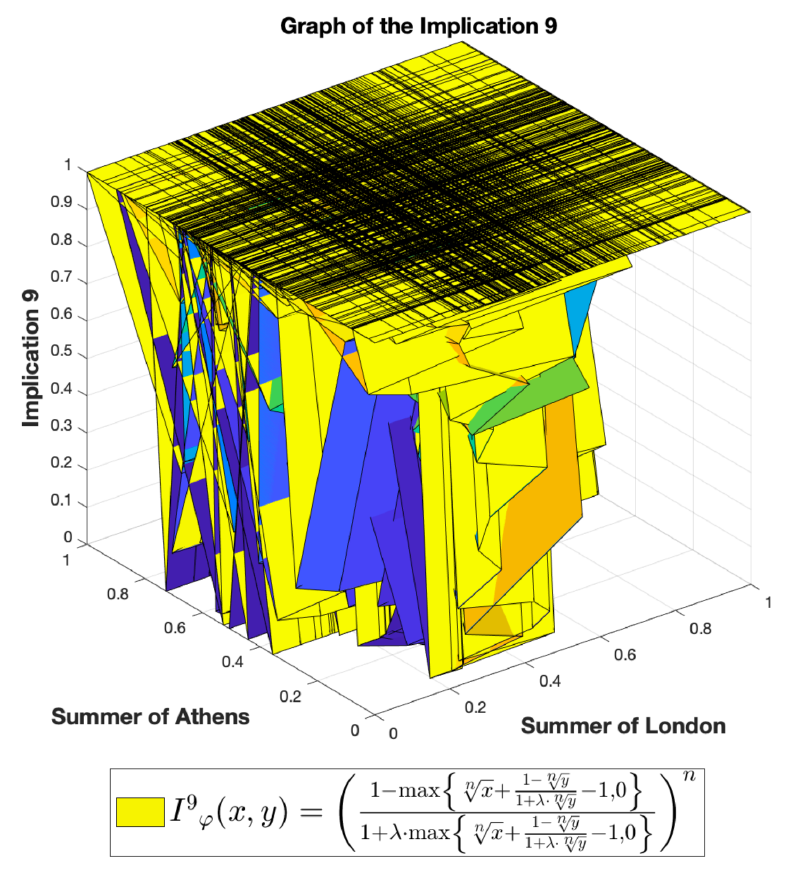
Figure 11. Graph of the Implication